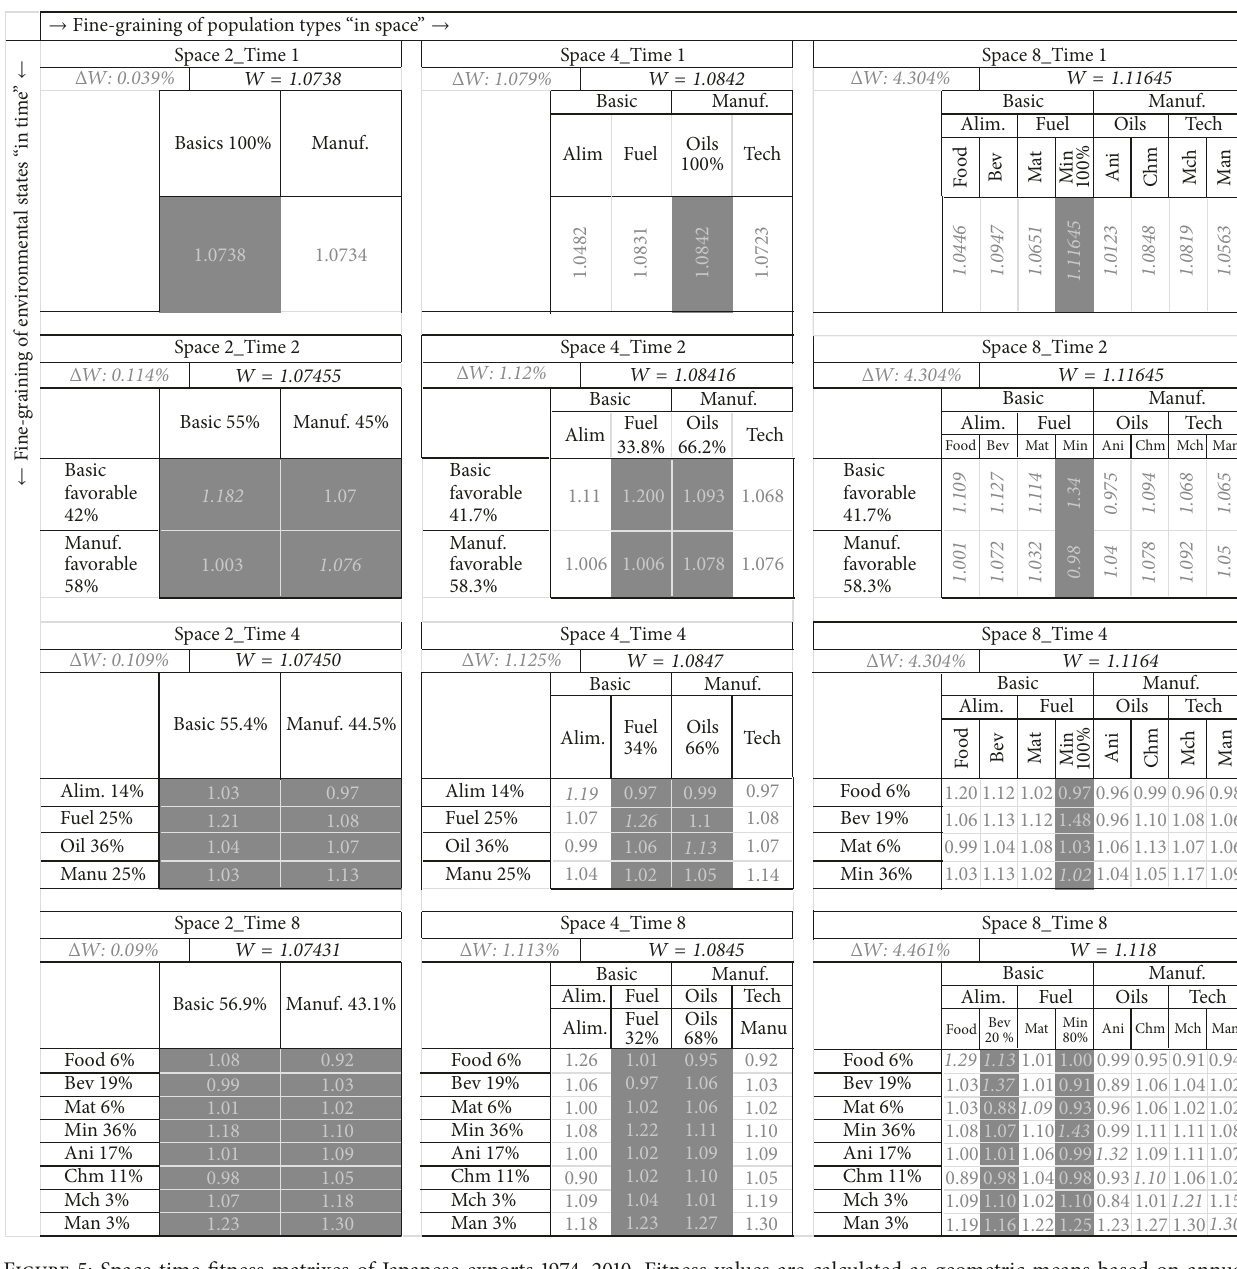
Figure 5: Space-time fitness matrixes of Japanese exports 1974–2010. Fitness values are calculated as geometric means based on annual averages. Horizontal types are based on Figure 4 (see for full names of types). Vertical environmental states are identified by superior relative fitness of a type within a squared split (see text). Fitness optimization suggests placing resources only at the shaded types, while nothing should be bet on the nonshaded ones. Optimal population shares were calculated with constrained nonlinear optimization algorithms in R (NLoptr). The values we calculated with the Augmented Lagrangian Algorithm, using the Broyden-Fletcher-Goldfarb-Shanno method (auglag-lbfsg), and confirmed with the Sequential Quadratic Programming method (auglag-slsqp), as well as with Sequential Quadratic Programming